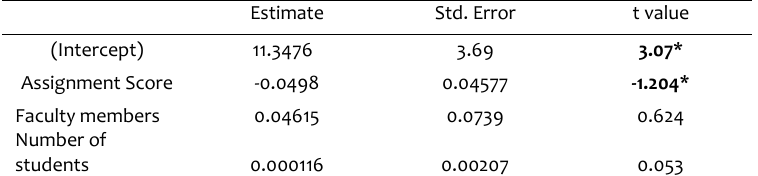
Table 8. Fixed Effects of the Third